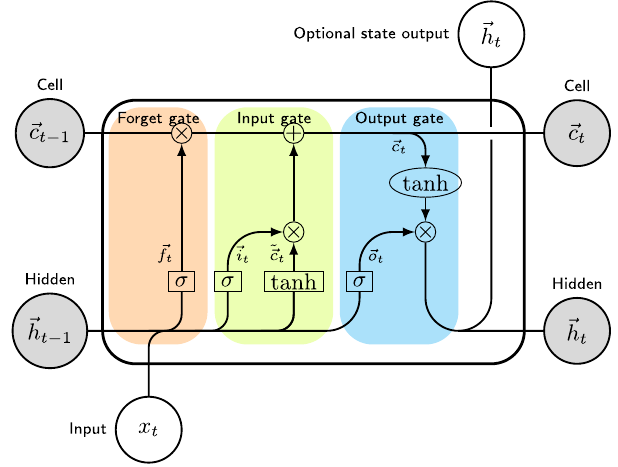
FIG. 4. The structure and updating scheme of an LSTM